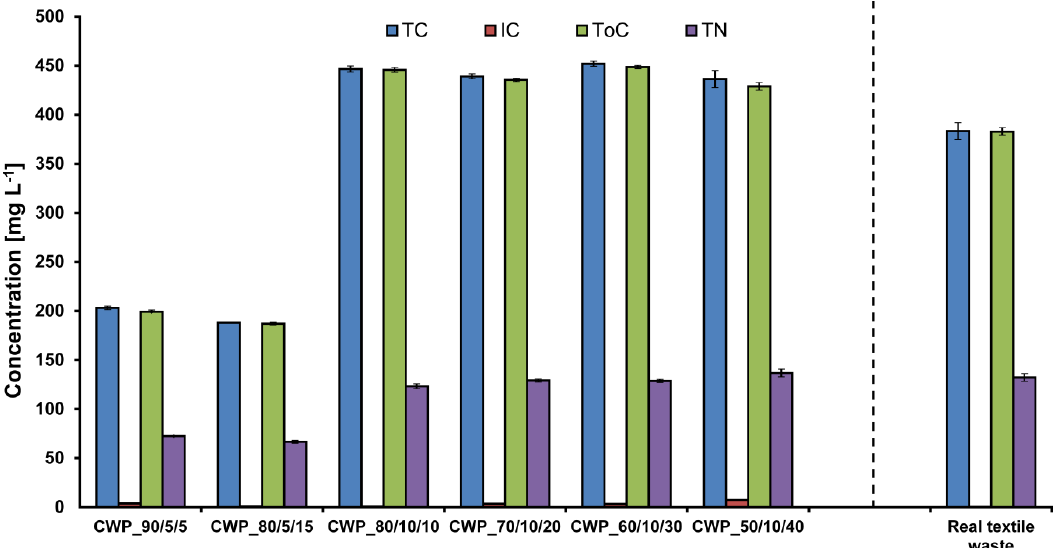
Figure 3. Determination of total carbon (TC), inorganic carbon (IC), total organic carbon (ToC) and total nitrogen of textile fiber sample hydrolysates after the protease treatment. Blank values from TC, IC, ToC and total nitrogen (TN) were subtracted.